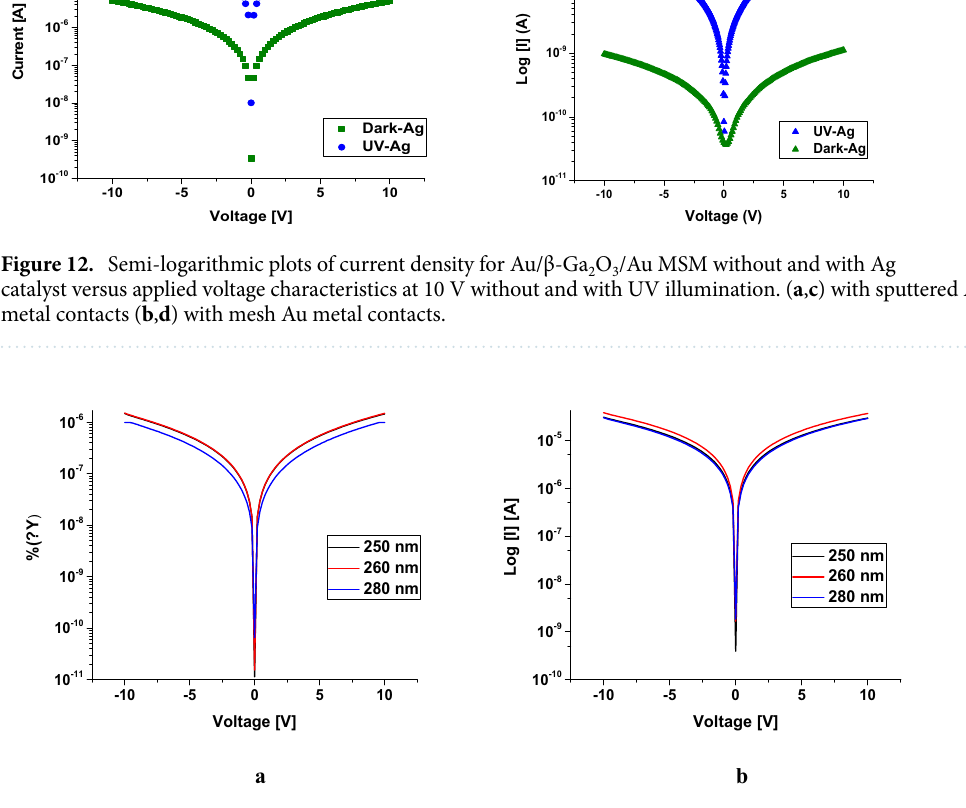
Figure 13. ( a ) semi-logarithmic plot of current–voltage for Au/β-Ga 2 O 3 /Au MSM with UV illumination at 10Vat different wavelengths such as 250 nm, 260 nm and 280 nm. ( a ) without catalyst ( b ) with Ag